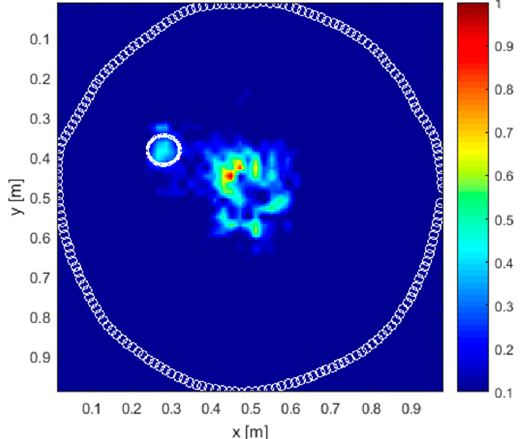
Figure 11. Tomographic reconstruction of the circular hardwood tree scenario with time-gating up to 6 ns. The dashed white circle indicates the actual position of the anomaly. The circles in white solid line along the trunk perimeter represent the positions of the measurement points.